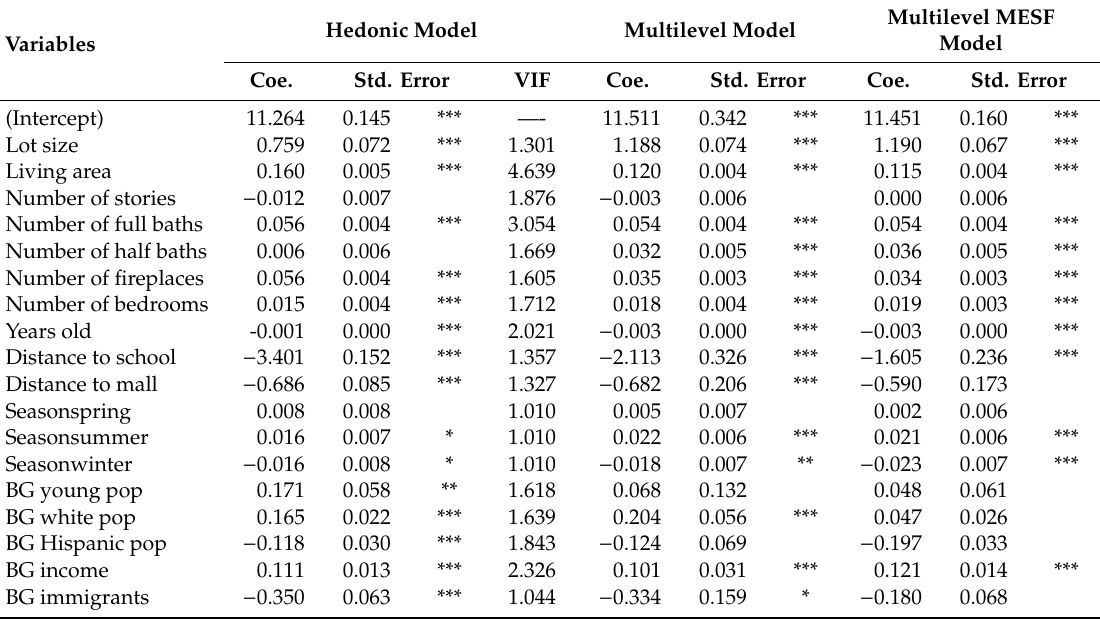
Table 3. Estimation results for the three di ff erent model